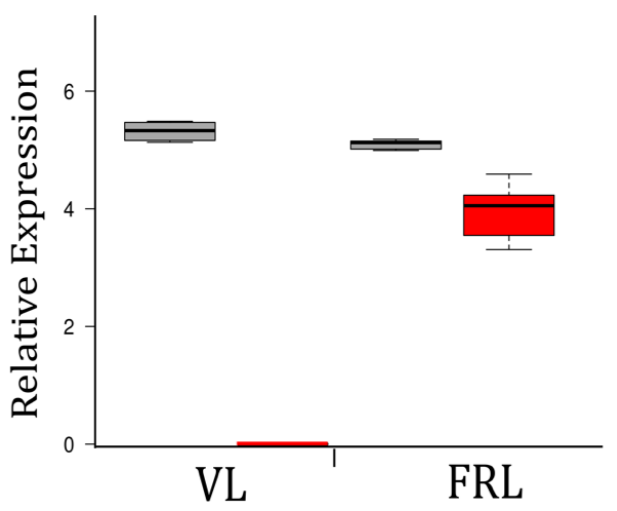
(Figure 6), confirming the function of ChlF in the FaRLiP response of endolithic Chroococ- cidiopsis . Ct values for chl F were comparable to values for rpoC2 , indicating nonnegligible levels of expression for chl F in FRL.